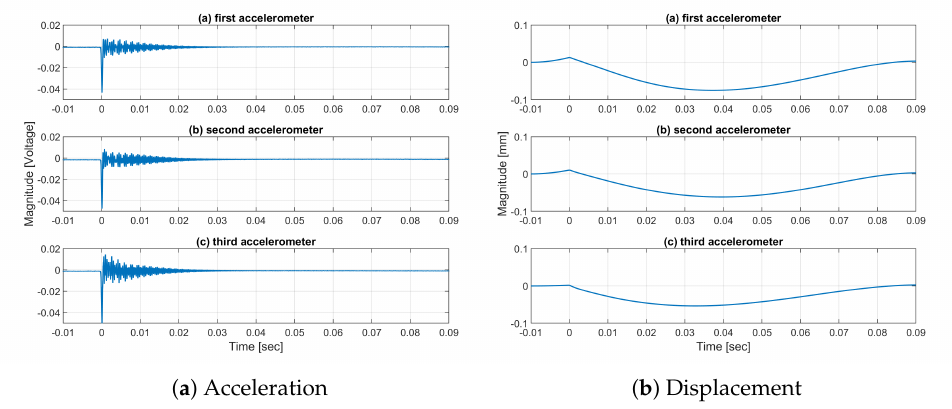
Figure 9. Typical acceleration and displacement results of the 25 mm glued 60 grit